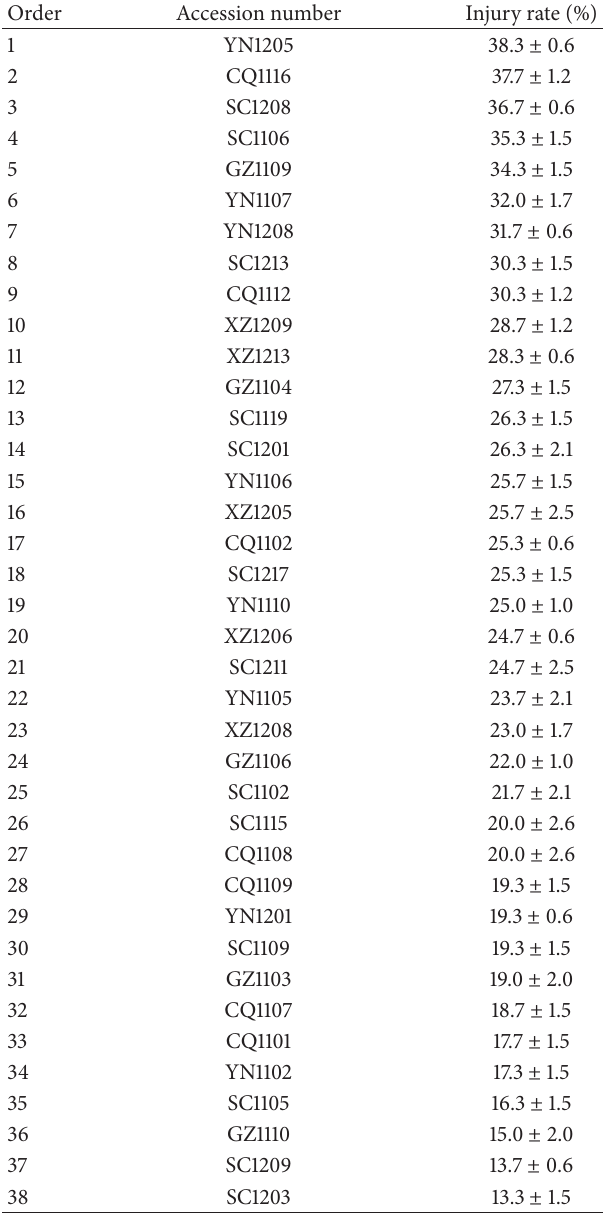
Table 2: Leaf injury rate of 38 wild C. dactylon accessions under SO stress